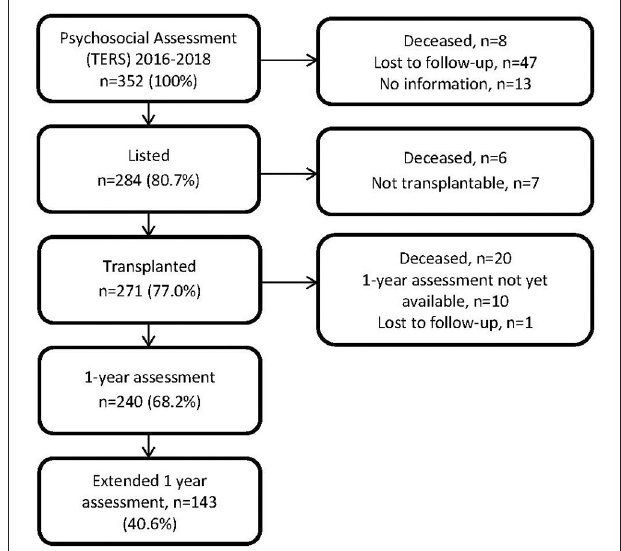
FIGURE 1 | Flowchart of participating